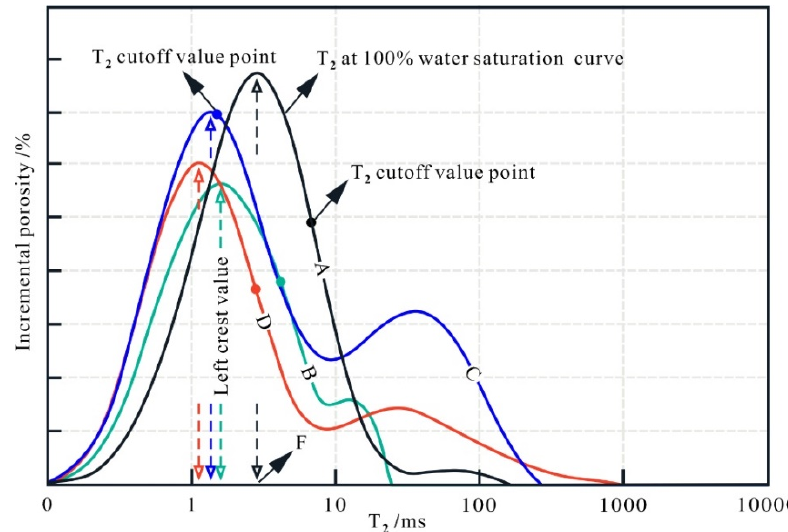
Figure 12. T 2 spectra of bimodal morphological at 100% water saturation.